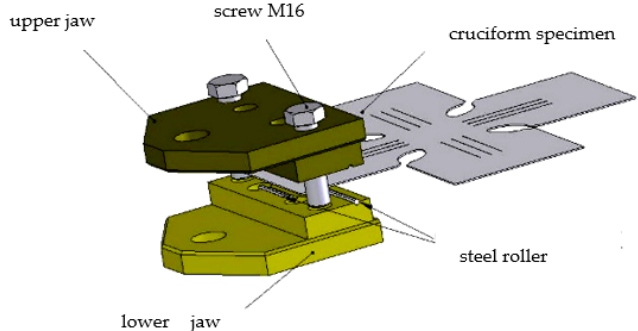
Figure 2. The jaw cross-clamping mechanism.